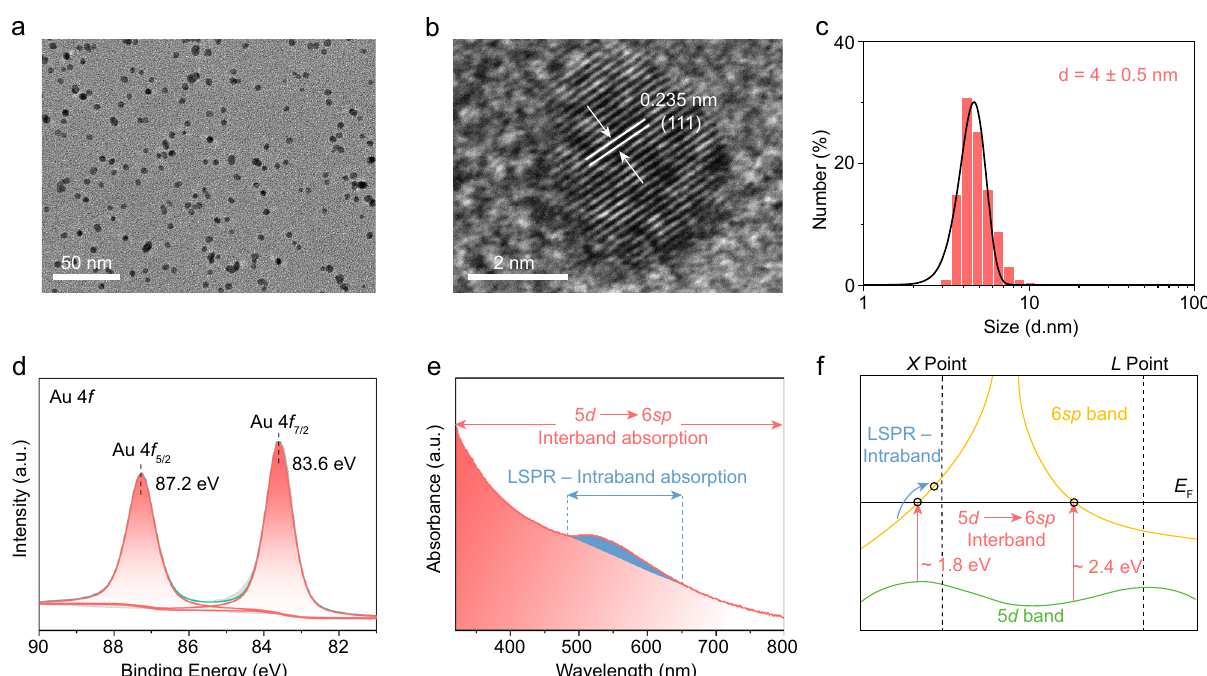
Fig. 1 Materials characterization. a Typical TEM image, b HRTEM image, and c Particle size distribution of Au NPs. d Au 4 f XPS spectra of as-prepared Au NPs. e UV – Vis absorption spectrum of the Au NPs with interband and intraband absorption. f Schematic diagram of interband and intraband (LSPR)